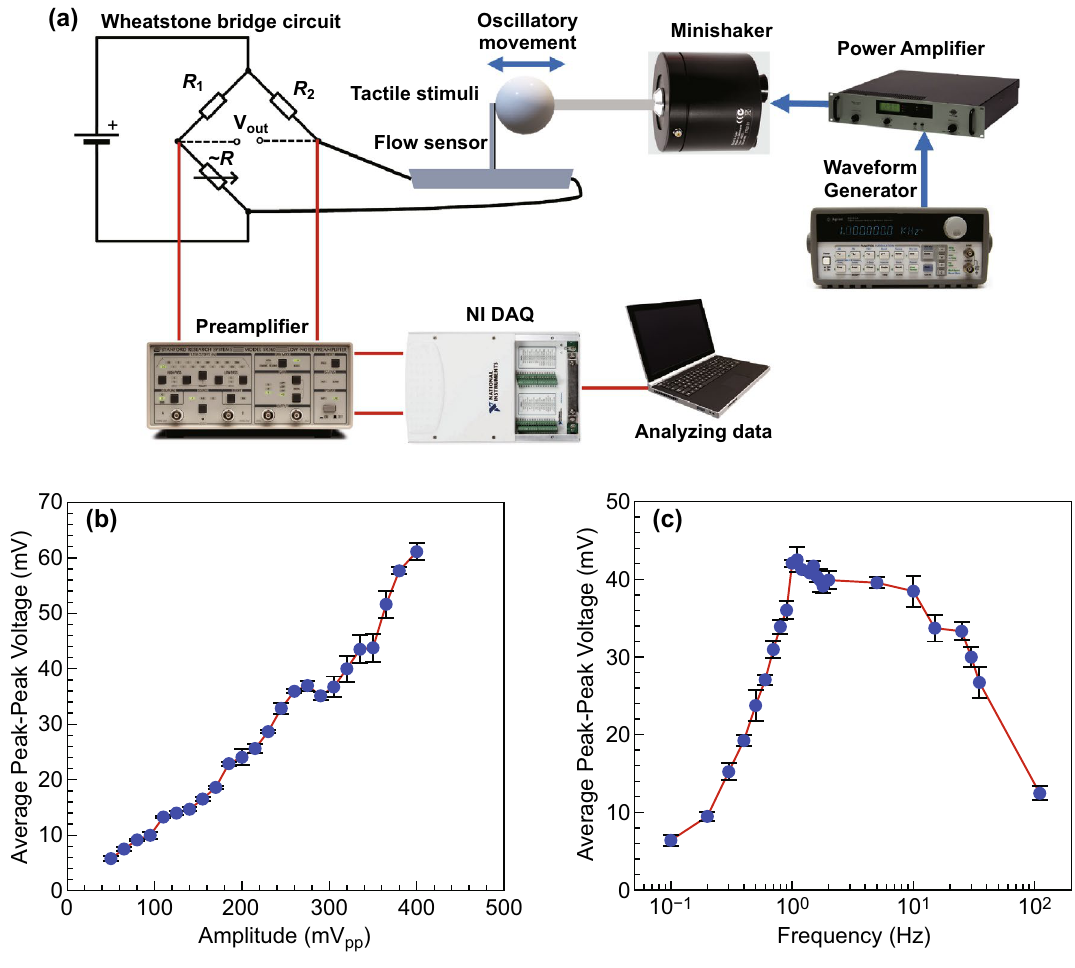
Fig. 2 a Schematic diagram of the experimental setup for oscillatory stimuli in contact with the sensor (in air). b Average peak-to-peak voltage as a function of amplitude at f = 10 Hz. c Average peak-to-peak voltage as a function of frequency at amplitude of 354 mV